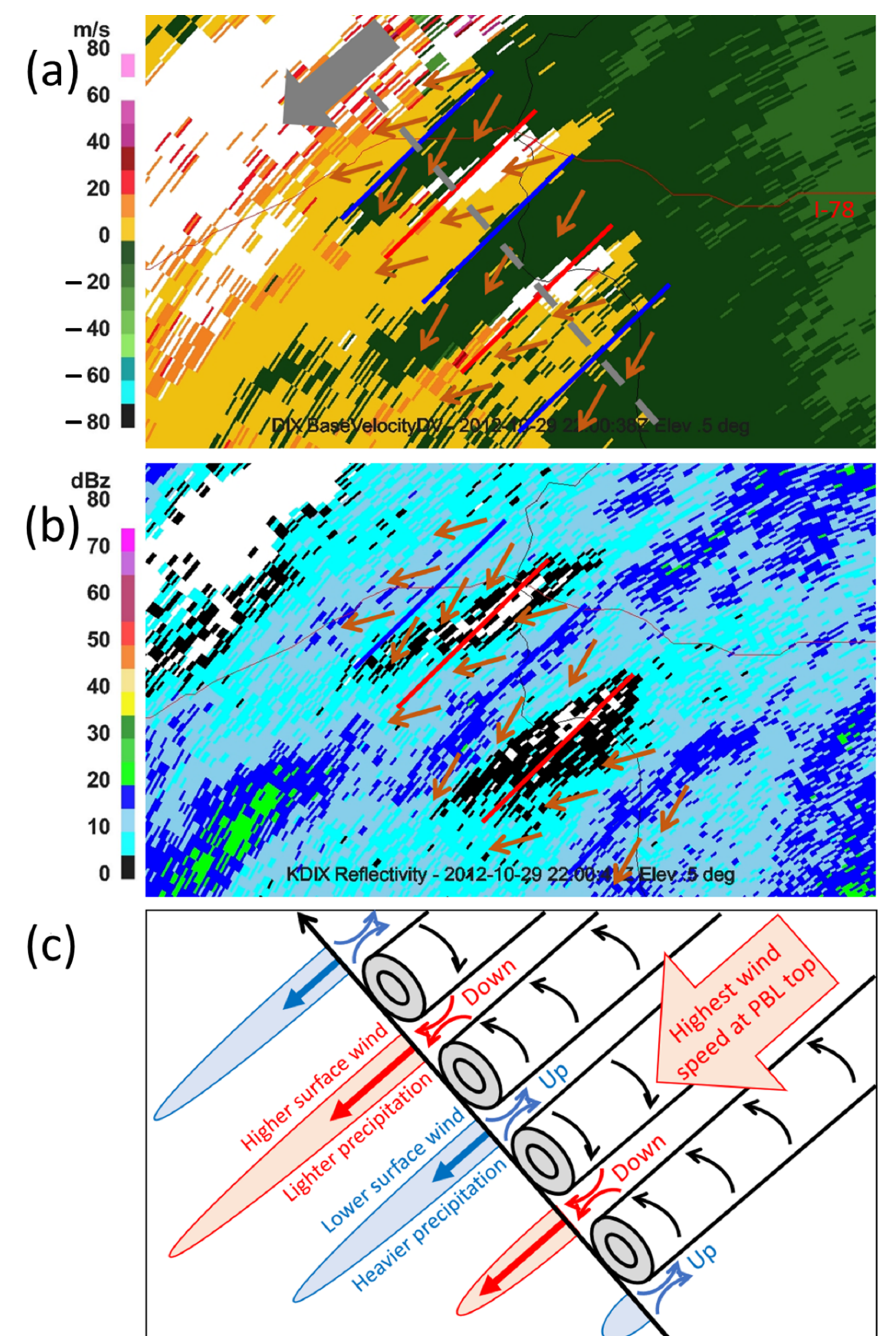
Figure 5. The radar ( a ) radial velocity and ( b ) reflectivity for the region identified by the black rectangle on Figure 2a,b. The radar site is located about 80 km southeast of the region shown. Elevation of the radar scan within this region is about 1.5 km height. The approximate mean wind direction is indicated by the thick gray arrow. Yellow (green) in ( a ) indicates a flow component away from (toward) the radar site. Brown arrows in ( a , b ) indicate, qualitatively, the horizontal flow direction inferred from the radar radial velocity. Blue (red) lines in ( a , b ) indicate areas of convergence (divergence). Figure ( c ) shows a conceptual diagram of rolls. Elliptical cylinders represent rolls, and the curved red (blue) arrows between rolls represent downward (upward) motions. The red and blue shaded patches indicate impacts of rolls on total surface wind speed and precipitation.